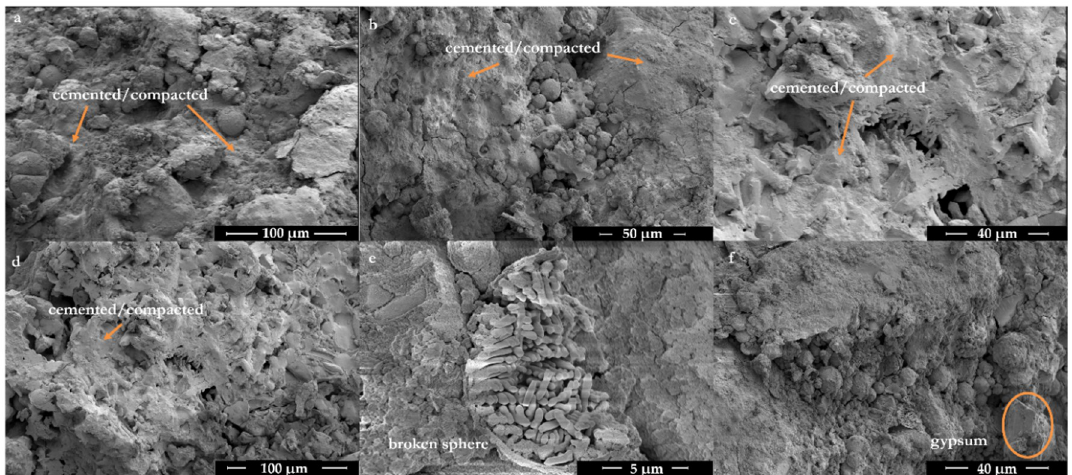
Figure 9. SEM image of SO-CFA-28 sample. Cemented and compacted structure at various magnifications ( a ) 700× magnification, ( b ) 1000× magnification, ( c ) 1500× magnification, ( d ) 700× magnification; ( e ) rod-like structure at 10,000× magnification; ( f ) presence of gypsum at 1500× magnification.